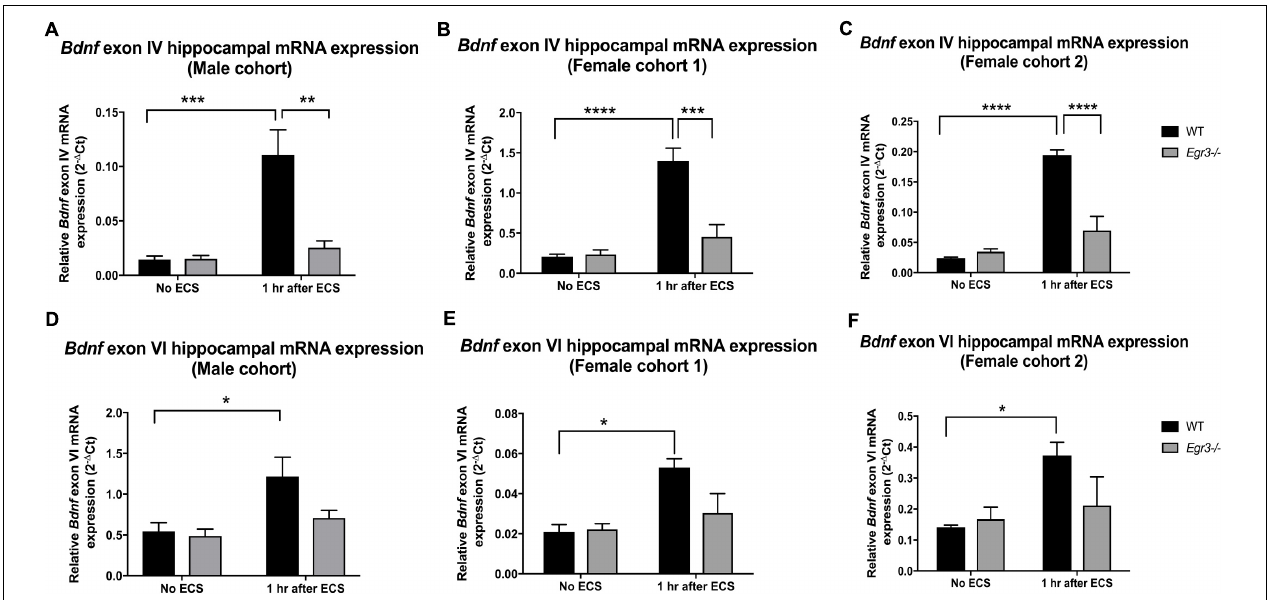
FIGURE 2 | Electroconvulsive seizure (ECS)-mediated hippocampal induction of Bdnf exon IV and VI requires Egr3 . Exon IV (A–C) and VI (D–F) hippocampal Bdnf expression determined using qRT PCR from WT, and Egr3 –/–, mice at baseline (no ECS) and 1 h after ECS. Two-way ANOVAs showed significant interactions of genotype and ECS treatment on Bdnf exon IV expression in (A) original male cohort data ( p = 0.0041), (B) female cohort 1 ( p = 0.0019), and (C) female cohort 2 ( p = 0.0001). Two-way ANOVAs showed significant effect of treatment on Bdnf exon VI expression in original (D) male cohort ( p = 0.0099), (E) female cohort 1 ( p = 0.0064), and (F) female cohort 2 ( p = 0.0237; n = 4–5 animals/group; ∗ p < 0.05, ∗∗ p < 0.01, ∗∗∗ p < 0.001, and ∗∗∗∗ p < 0.0001 controlled for multiple